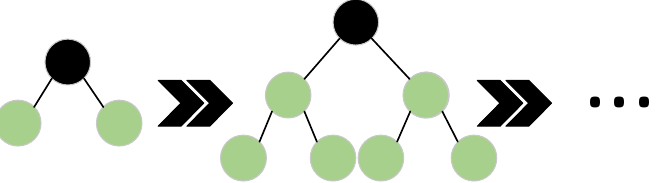
Figure 2. Schematic diagram of growth by layer. (Black nodes represent generated nodes in the tree; green nodes represent newly generated nodes at the current time step.).